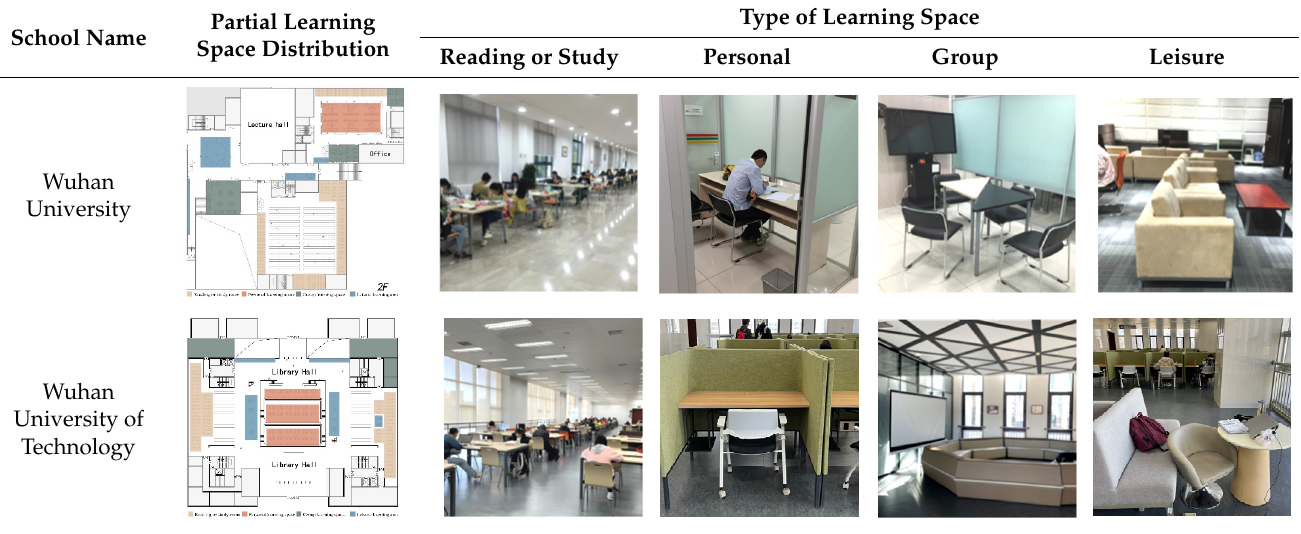
Table 4. Distribution of learning space types in the two universities.